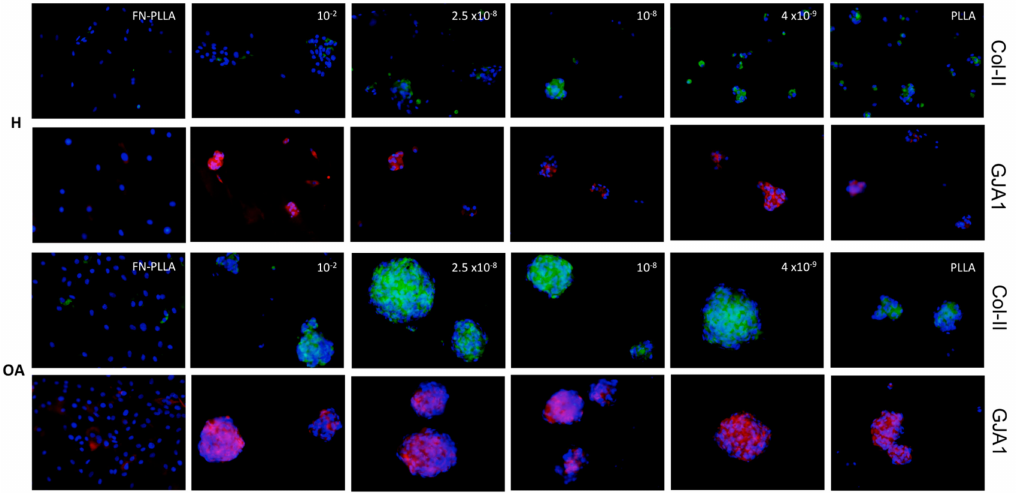
Figure 2. Collagen type-II (Col-II) and connexin 43 (expressed by the gap junction protein alpha 1, GJA1) immunofluorescence counterstained with DAPI, in healthy (H)- and osteoarthritic (OA)-derived bone marrow mesenchymal stromal cells (BM-MSCs) aggregates formed after three days, under chondrogenic medium (CM), in RGD-Cys-D1 PLLA nanopatterned substrates (10 − 2 , 2.5 × 10 − 8 , 10 −